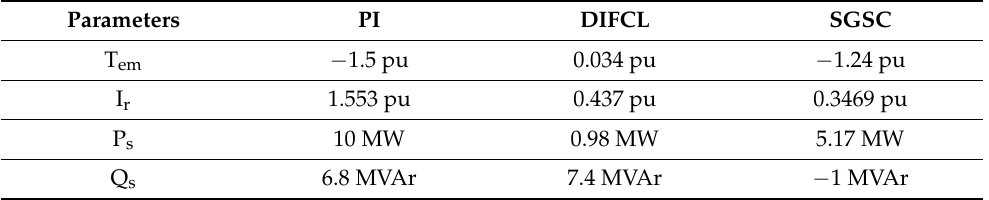
Table 2. Comparative analysis of responses of different control schemes during symmetrical